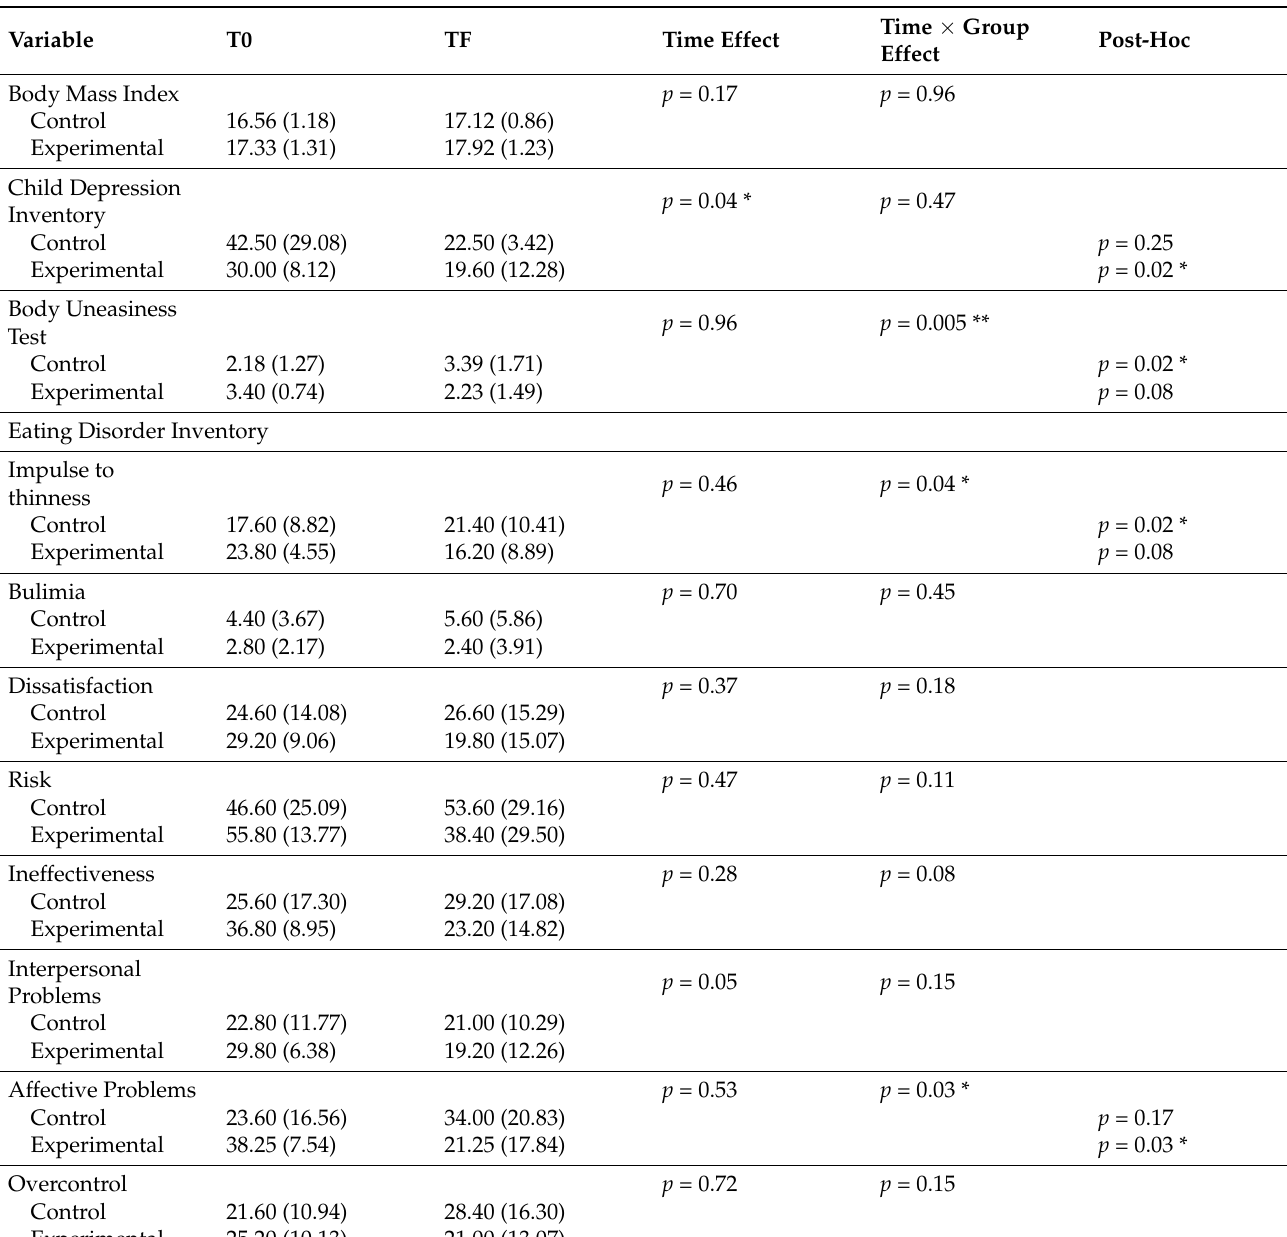
Table 2. Difference in clinical variables from T0 to TF in control and experimental groups.